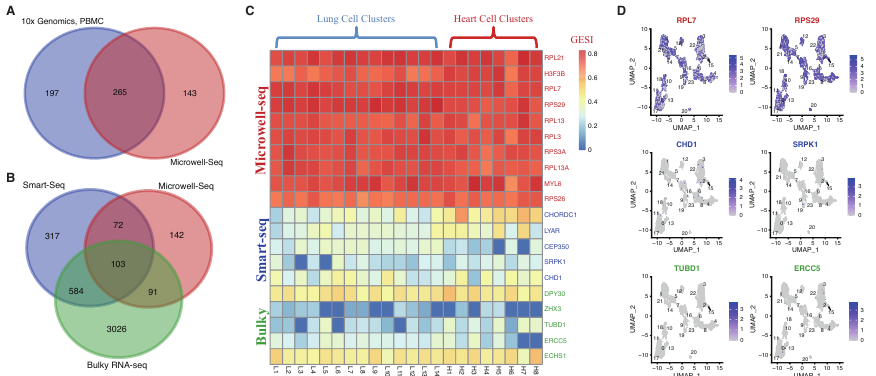
Figure 2. Comparison of SEGs identified from different datasets. ( A ) Comparison of the spatial- temporal SEGs (Microwell-Seq) and PBMC SEGs identified from 10x Genomics scRNA-Seq datasets. ( B ) Comparison of the Microwell-Seq SEG, Smart-Seq SEG [3] and bulky RNA-seq HKG lists [1]. ( C ) GESI heatmap of representative genes inconsistent among the Microwell-Seq SEG, Smart-Seq SEG and bulky RNA-seq HKG lists. Ten Microwell-Seq SEGs, five Smart-Seq SEGs and five bulky RNA-seq HKGs not covered by the other two gene lists (from the specific subsets shown in Figure 2B) were selected randomly, and their cellcluster GESIs in two representative samples were shown. The samples were randomly selected from [25], both of which were from adult tissues. ( D ) Expression of two representative SEGs/HKGs specifically detected by Microwell-Seq ( RPL7 and RPS29 ), Smart-Seq ( CHD1 and SRPK1 ) or bulky RNA-seq ( TUBD1 and ERCC5 ) in single-cell clusters of a representative sample. The representative sample (an adult lung sample) was selected from [25]